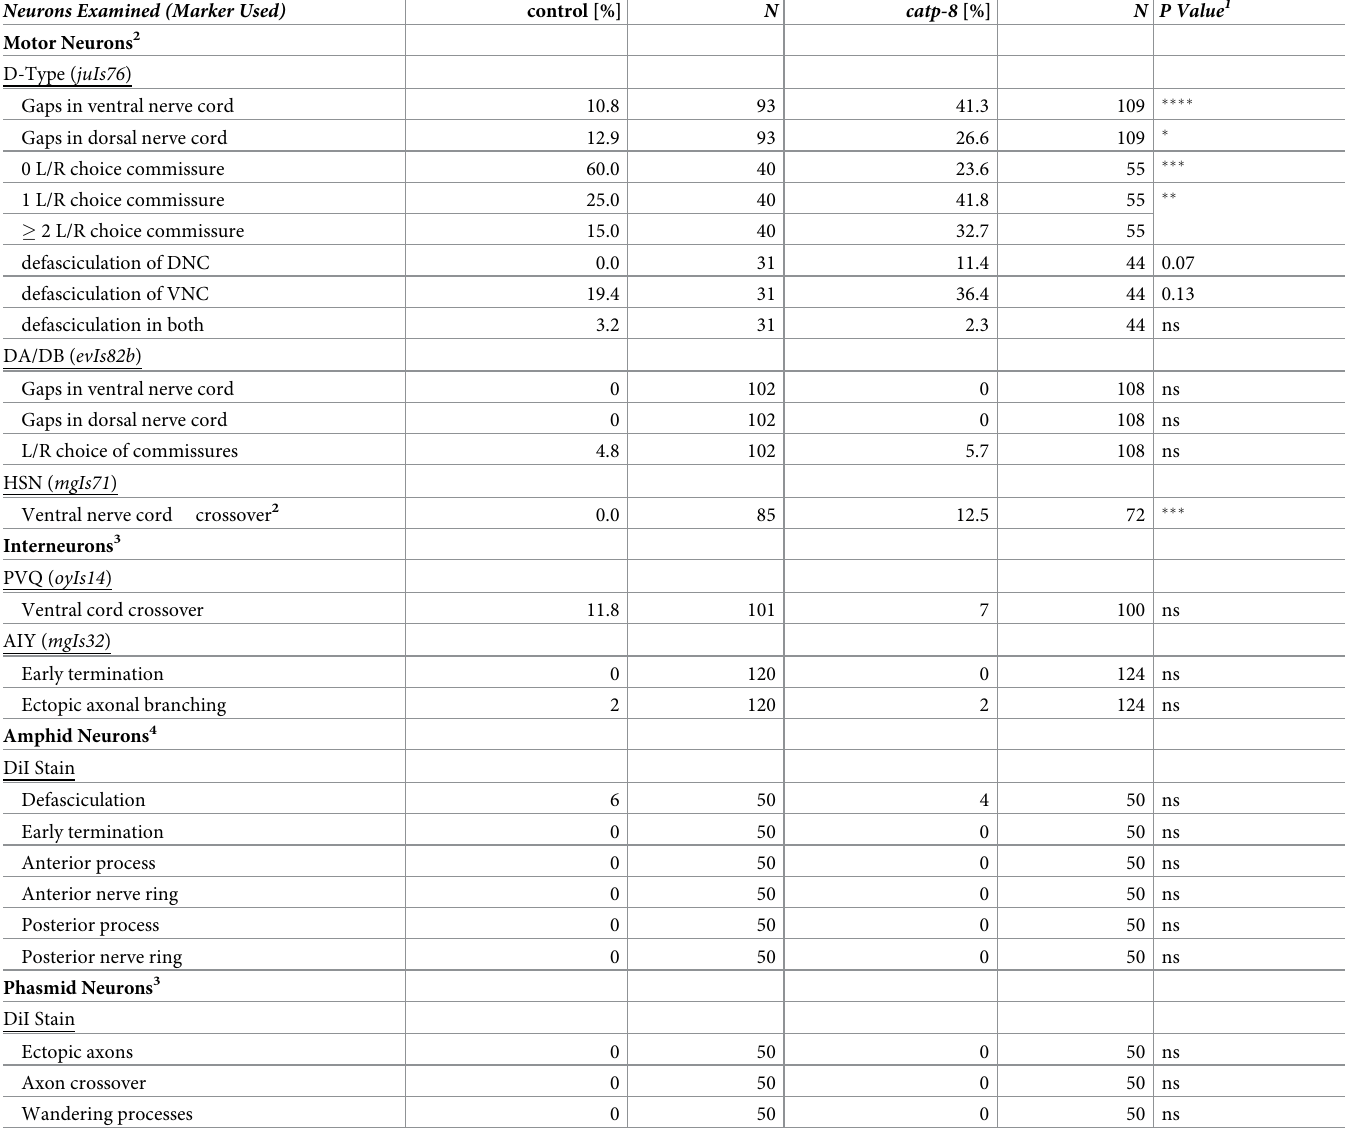
Table 1. Survey of neuroanatomical defects in catp-8/P5A-ATPase mutant animals. Neurons Examined (Marker